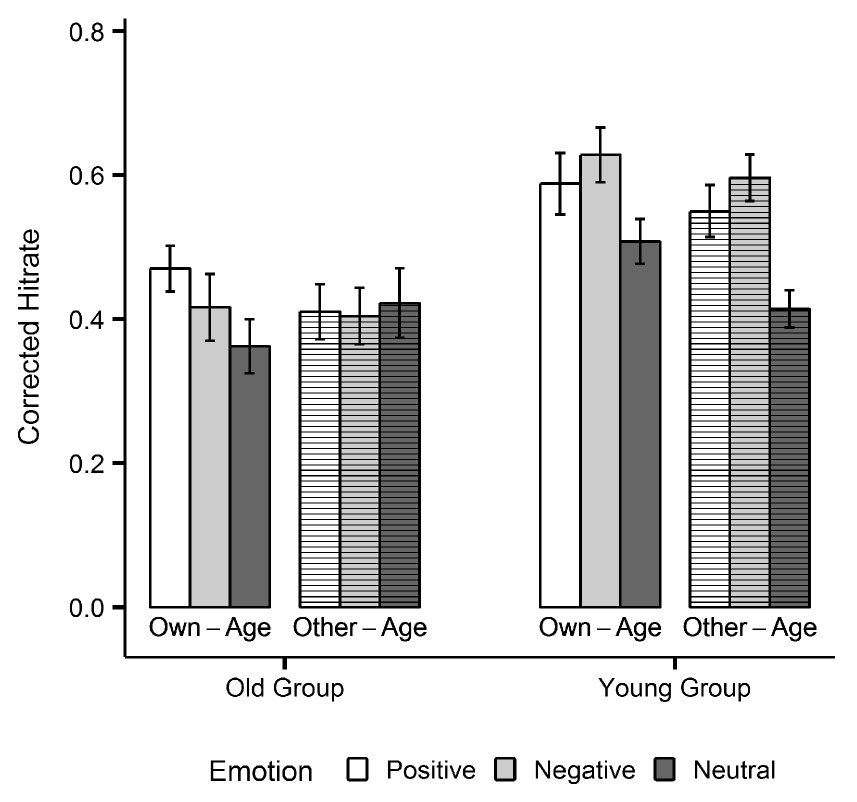
Figure 7. Memory data. Corrected hit rates for positive, negative and neutral own-age and other-age stimuli, plotted separately for each age- group. Error bars represent standard errors of the mean.